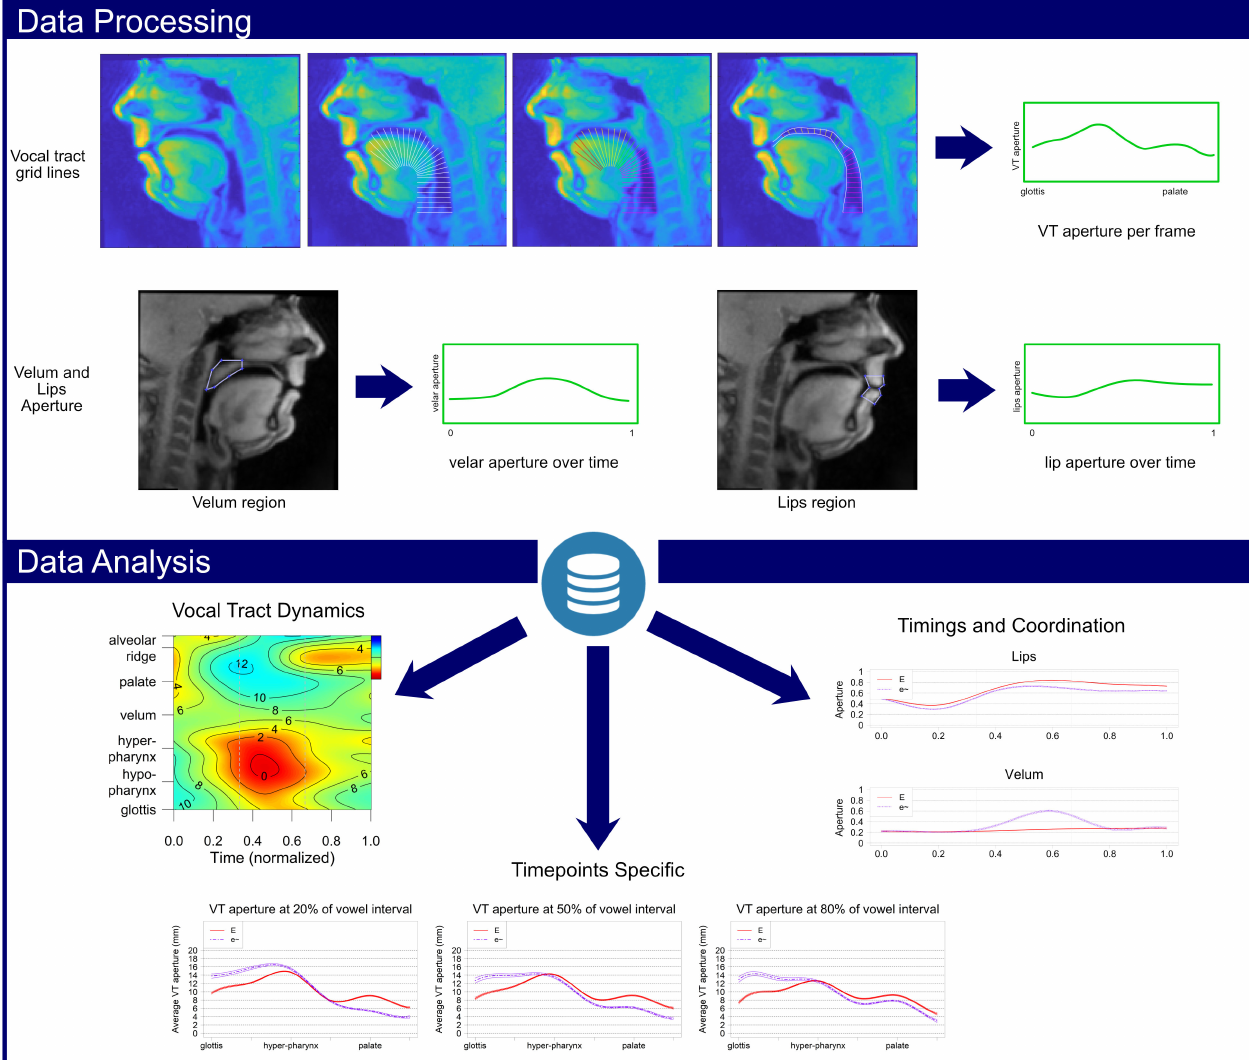
Figure 1. Diagram depicting the main steps of the adopted processing and analysis methodology.